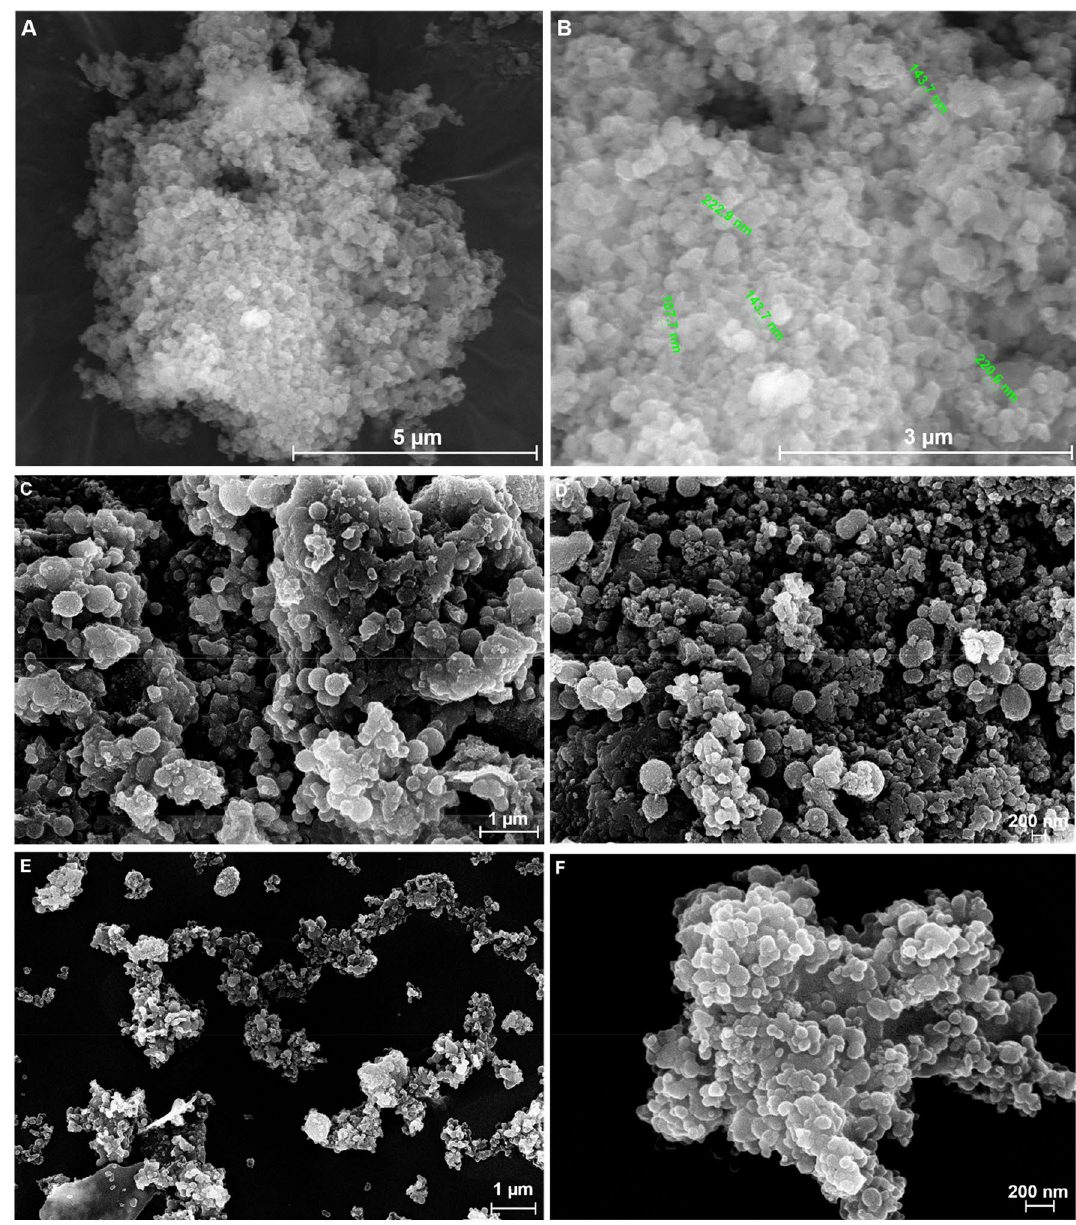
Figure 3. SEM images of the magnetic catalysts: Fe 3 O 4 @SiO 2 -DCG ( A , B ), Fe 3 O 4 @SiO 2 -DIG ( C , D ) and